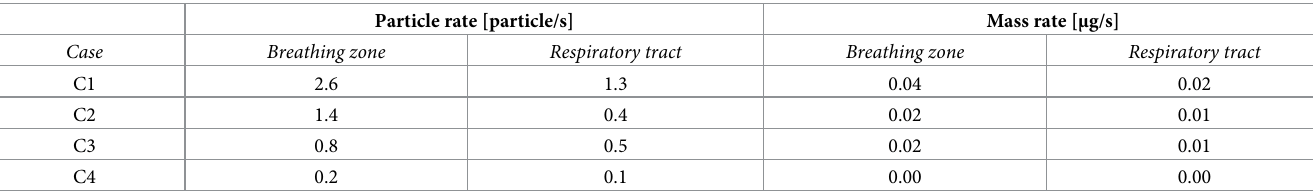
Table 1. Particle and mass rate in the breathing zone and deposited in the respiratory